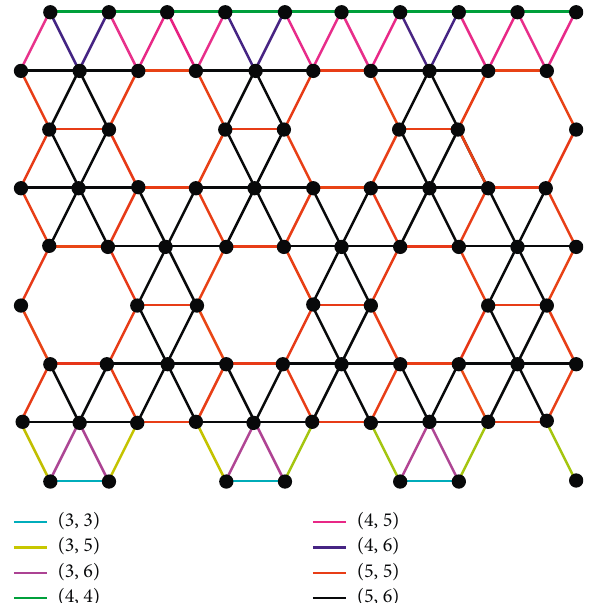
Figure 6: The edge partitions of BA ( Y )[ 9 , 6 ] with respect to degree of end